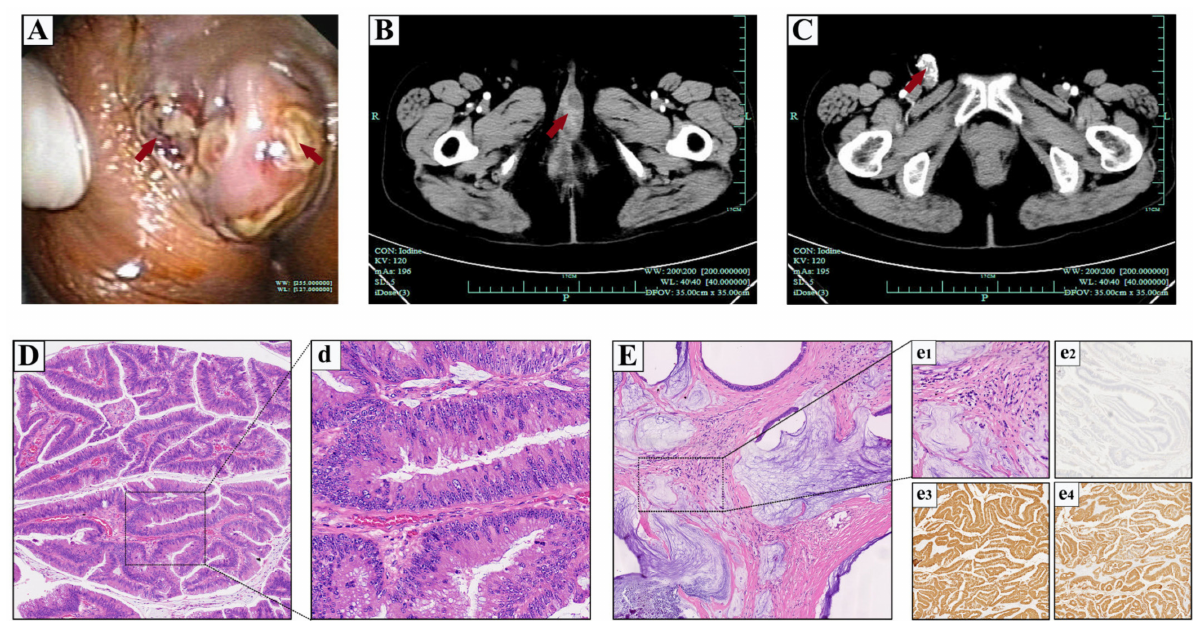
Figure 3. Cystourethroscopic, imaging examinations and histopathologic features of the Case 2 in 2016. ( A ) Cystourethroscopy show a pedicled mass at the external urethral orifice with approximate dimensions of 3.0 × 1.6 cm. ( B ) An enhanced pelvic CT scan indicated a 3.1 × 1.9 cm solid cystic mass adhering on the external urethral orifice, and uneven enhancement after contrast administration. ( C ) Enlarged lymph node with even enhancement were observed beside the right iliac blood vessel. Pelvic MRI demonstrated lesion surrounding the urethra. (Red arrows indicate the corresponding foci). H&E staining of low-power (( D ), 4 × 10 magnification) and high-power (( d ), 40 × 10 magnification) view showing the invasive mucinous type of primary urethral ade- nocarcinoma. Hematoxylin and eosin (H&E) staining of low-power (( E ), 4 × 10 magnification) and high-power (( e1 ), 40 × 10 magnification) view showing the right inguinal lymph node biopsy pathology confirming metastatic mucinous adenocarcinoma. Low-power view showing GATA-3 immunostain (( e2 ), 4 × 10 magnification, negative), CK20 immunostain (( e3 ), 4 × 10) magnification, strong positive), and CDX2 immunostain (( e4 ), 4 × 10 magnification, strong